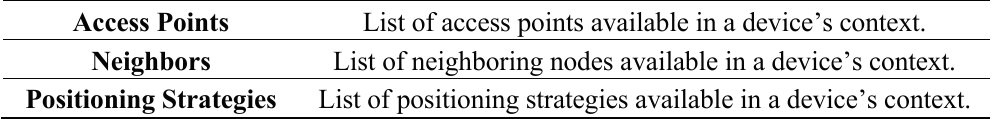
Table 2. Scenario feature